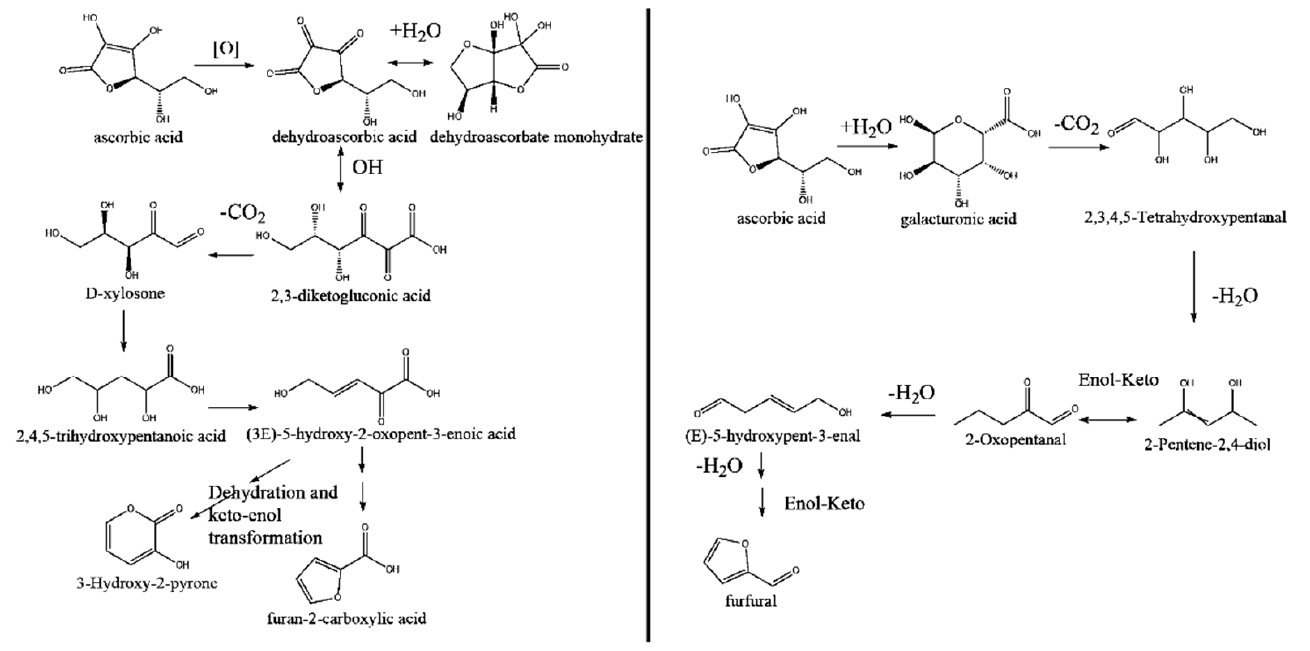
Figure 3. Mechanism of aerobic and anaerobic degradation of ascorbic acid. ( a ) aerobic degradation of ascorbic acid with the primary terminal product of degradation as 3-hydroxy-2-pyrone; ( b ) anaerobic degradation of ascorbic acid with the primary terminal product as furfural